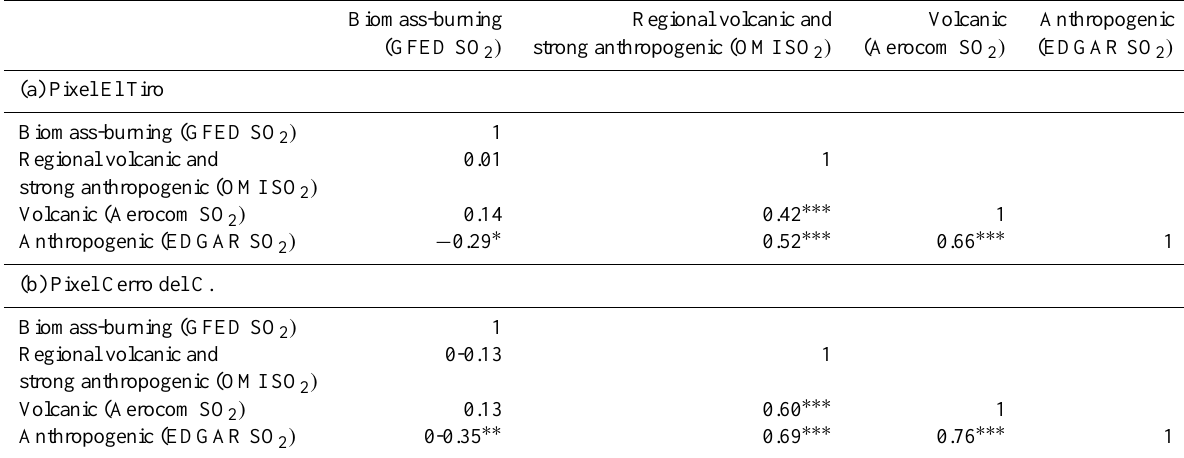
Table 2. Cross-correlation of calculated SO 2 concentration time series over El Tiro and Cerro del Consuelo SO 2 transport pixels using the different emission data